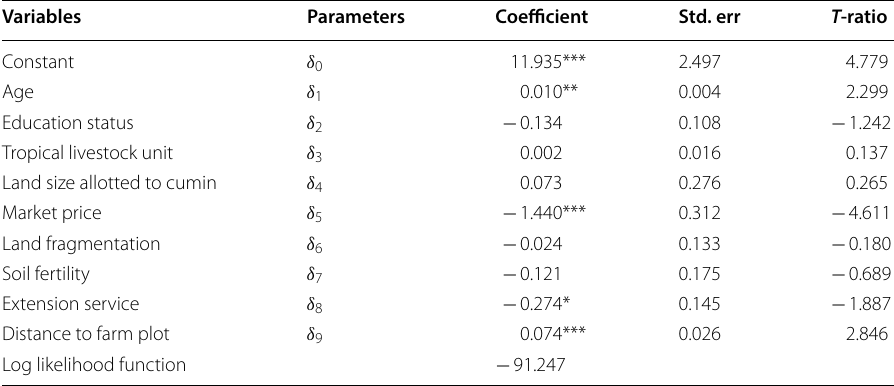
***, ** and * are statistically significant at 1%, 5% and 10%, respectively